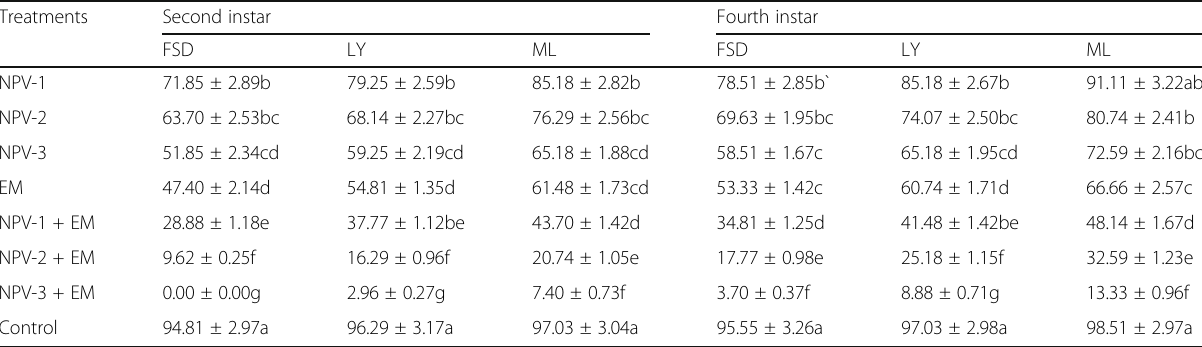
Table 2 Mean pupation (%±SE) of second and fourth larval instars of Spodoptera litura from three different field populations treated with nucleopolyhedrosis virus and emamectin benzoate. (NPV-1 2 × 10 9 POBs ml − 1 , NPV-2 3 × 10 9 POBs ml − 1 , NPV-3 4 × 10 9 POBs ml − 1 , EM 0.1